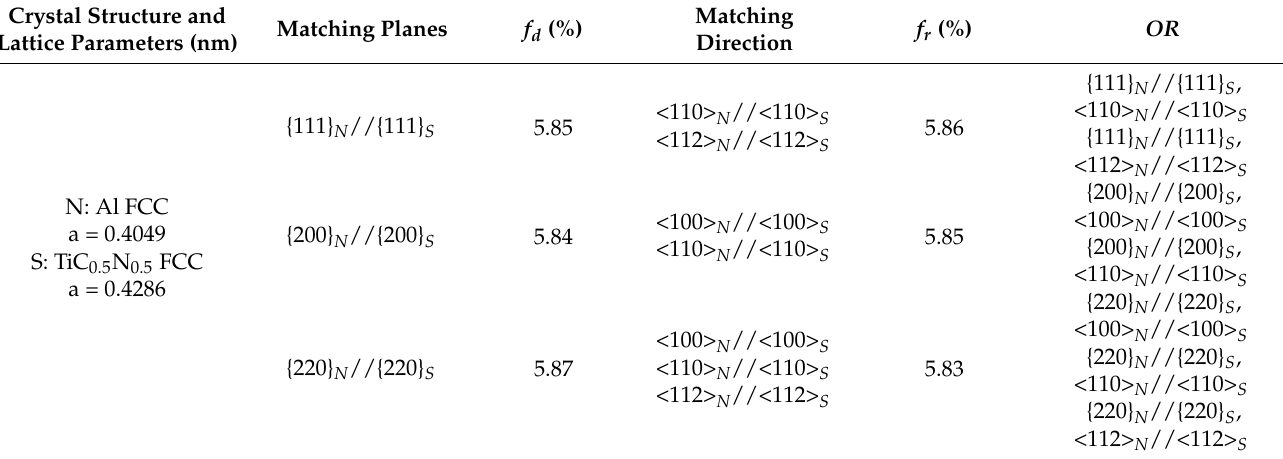
Table 1. Possible orientation relationships between TiC 0.5 N 0.5 and Al.